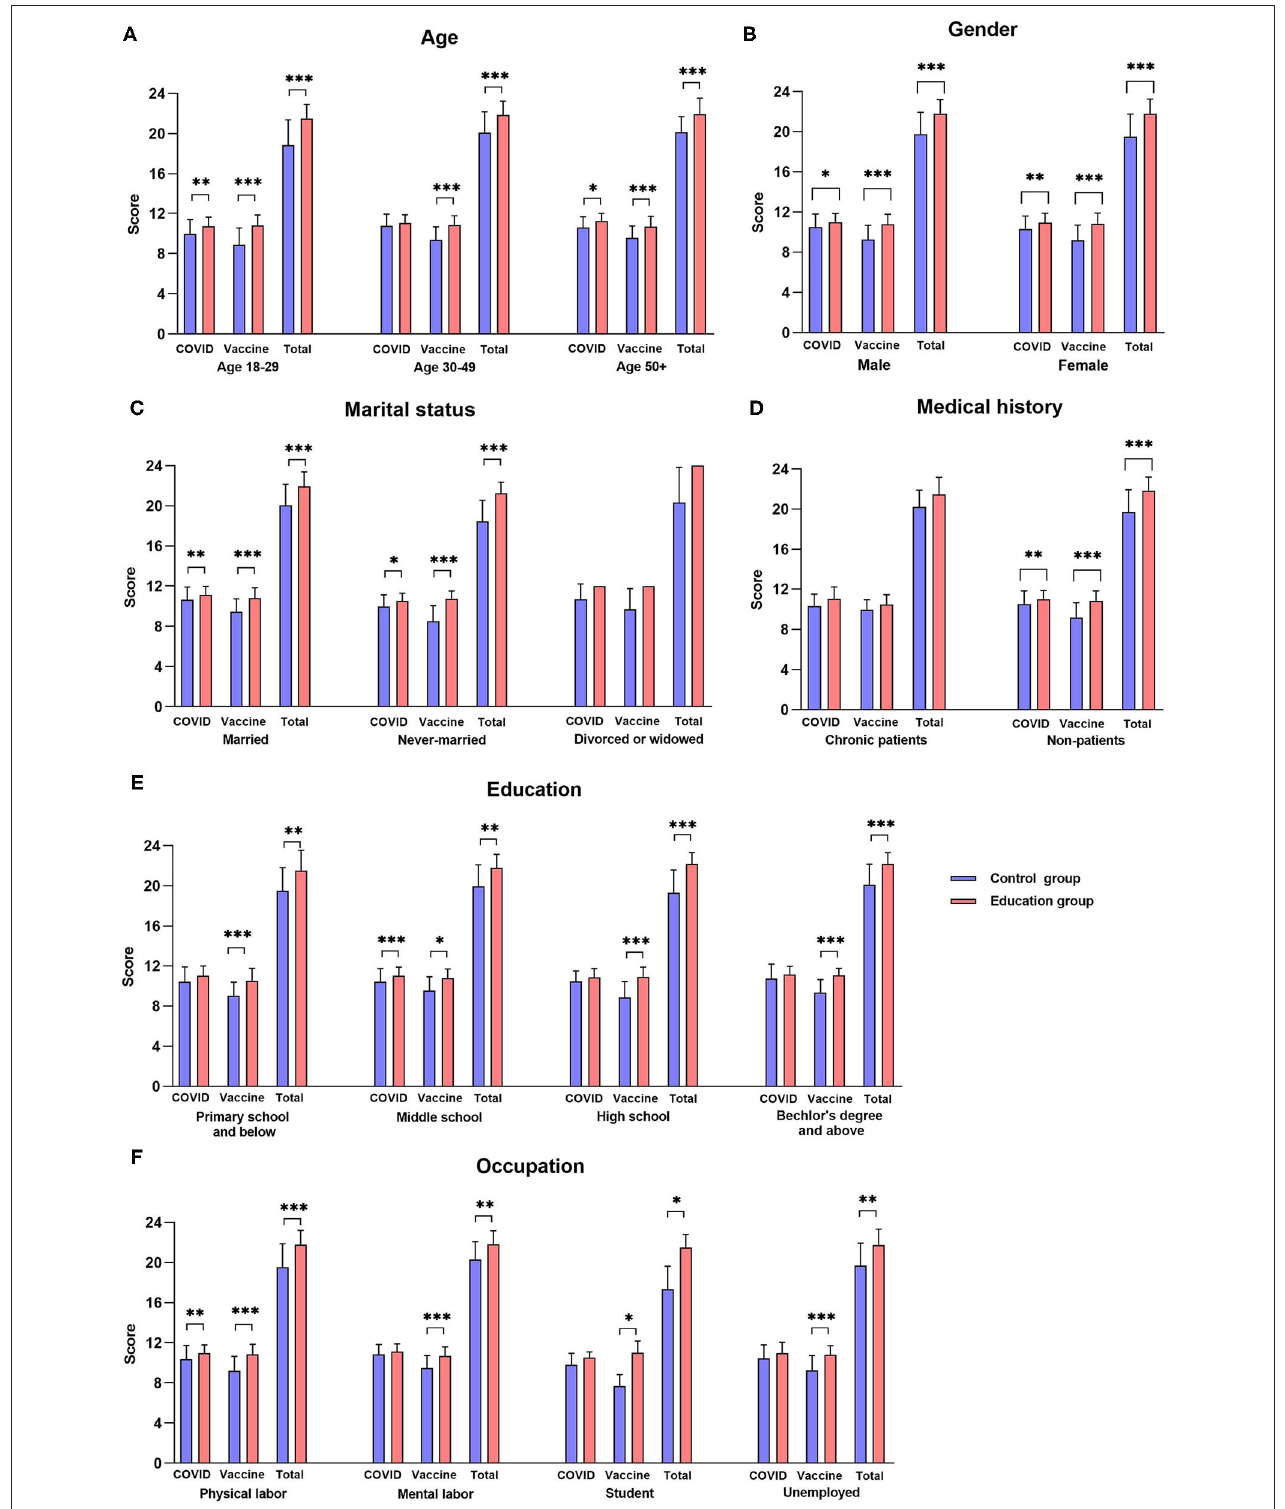
FIGURE 4 | Knowledge score of education group and control group by demographic variables. [* P < 0.05, ** P < 0.01, *** P < 0.001, (A) scores of different ages, (B) scores of different genders, (C) scores of different marital statuses, (D) scores of different medical histories, (E) scores of different education levels, (F) scores of different